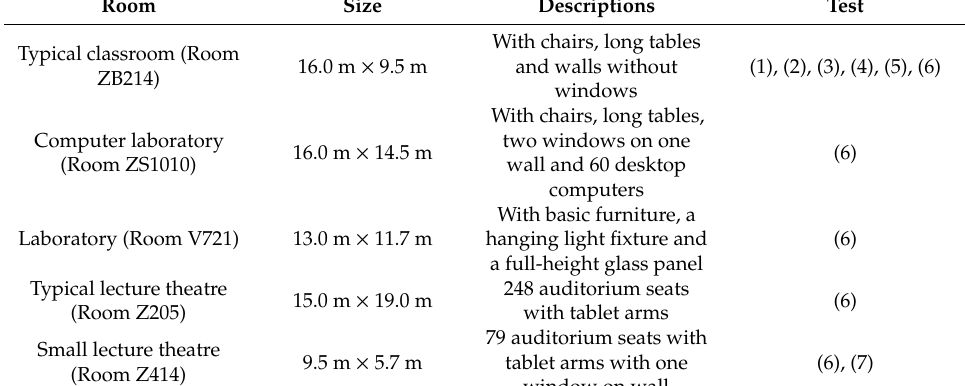
Table 2 . Classroom used for performance testing.